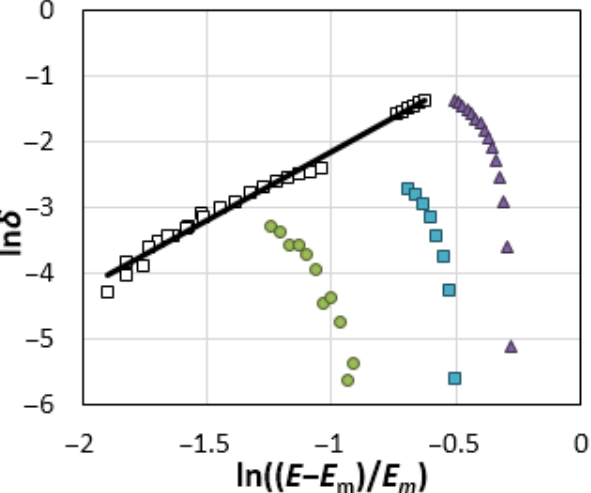
Figure 4. The dependences of the deformation coefficient of DEL δ = ∆ L / L Em on the reduced potential ( E − E m )/ E m in the logarithmic form for the Re electrode in NaCl ( ● ), KCl ( ▲ ) and CsCl ( ■ ) melts (with potentials more positive than the E c ) and in the range of potentials from E m to E c ( □ ) at 1093 K.